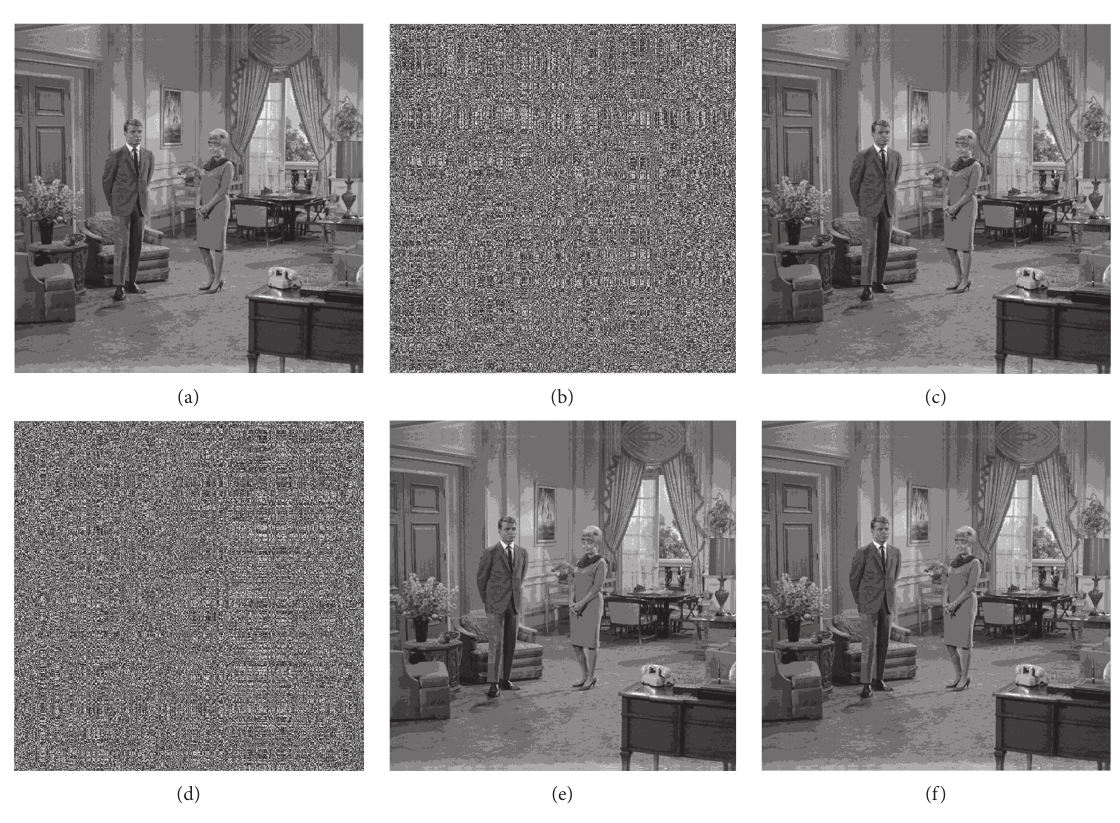
Figure 6: The plain image cipher image with the right key and the wrong key.